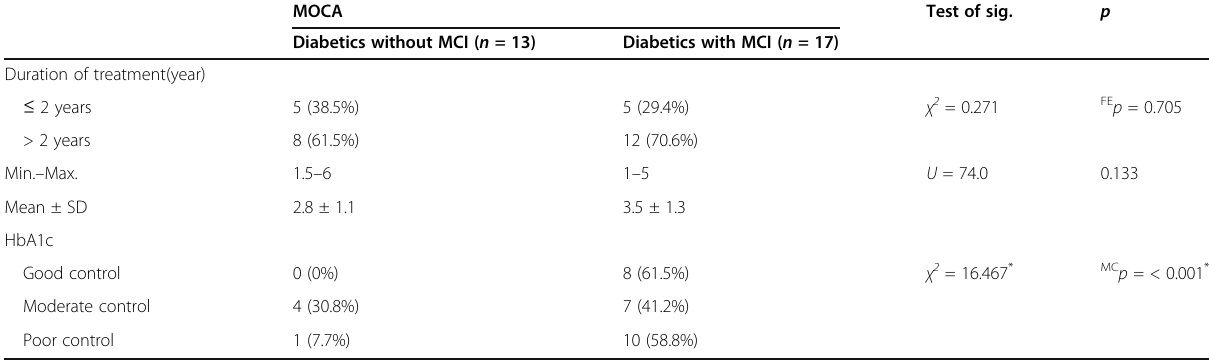
Table 3 Relation between Montreal Cognitive Assessment scale and duration of treatment in diabetic subjects MOCA Test of sig. Diabetics without MCI ( n = 13) Diabetics with MCI ( n = 17)